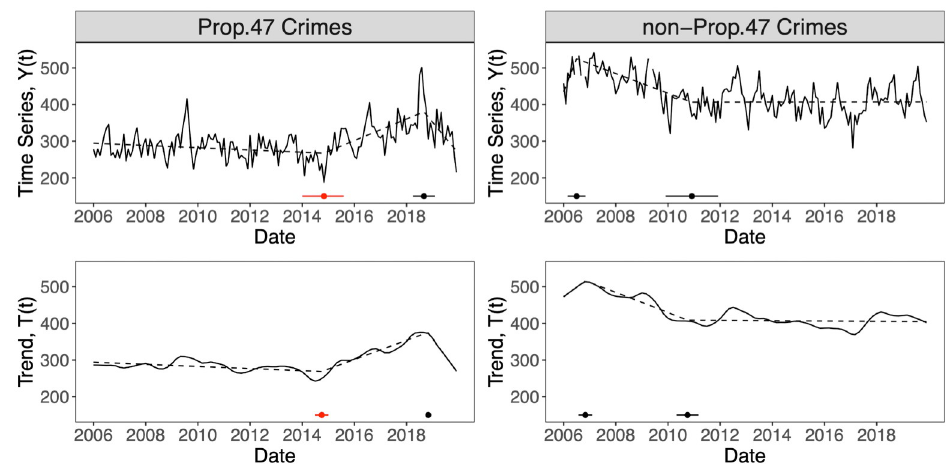
Fig 7. Segmented regression and breakpoint analysis of reported crime in Santa Monica, CA, 2006–2019. According to Davies’ test, the preferred model has two breakpoints. Top and bottom panels show segmented regression for, respectively, the original time series Y ( t ) and the smoothed trend T ( t ) with w trend = 19 months. Left panels are for Prop. 47 crimes and right panels are for non-Prop. 47 crimes. Breakpoints appear as dots and the respective 95% confidence intervals are marked by bars. For Prop. 47 crimes, the first breakpoint (red) is November, 2014 for Y ( t ) and October, 2014 for T ( t ). Values of 1 < w trend < 19 months preserve the T ( t ) breakpoint. The second breakpoint (black) is September, 2018 for Y ( t ), and October, 2018 for T ( t ). The first breakpoint signals a transition to higher crime for both Y ( t ) and T ( t ), the second one a decrease. For the non-Prop. 47 crimes, breakpoint dates are highly unstable and sensitive to changes in w trend